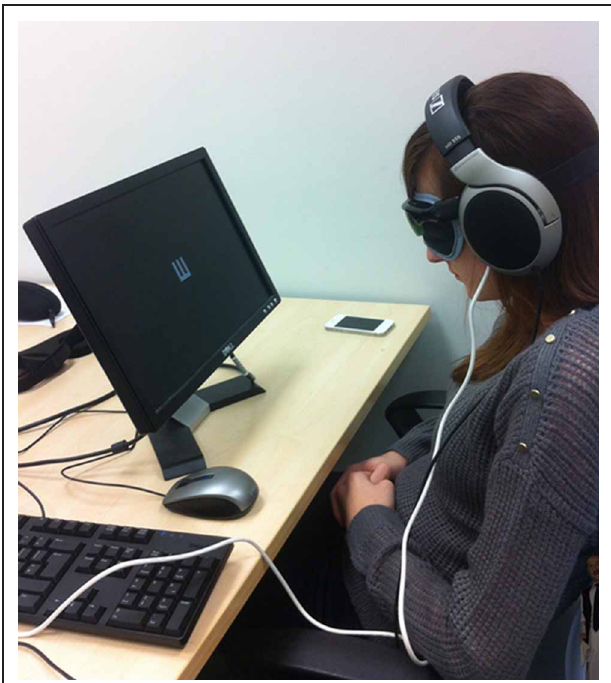
FIGURE 10 | Participant wearing camera glasses and listening to the soundscape produced from the camera’s view of the optotype displayed on